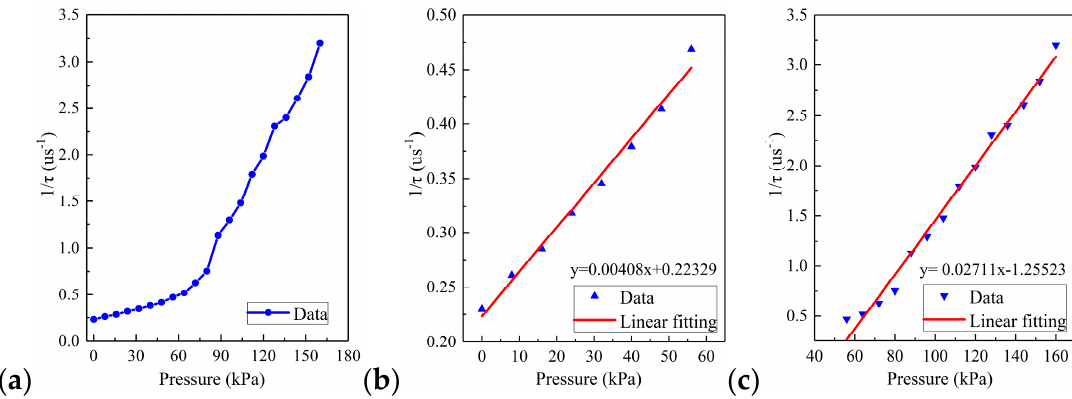
Figure 14. The relationship between the ring-down time and static ice pressure on the bottom; ( a ) ring-down time-pressure curve of the overall range of sensor; ( b ) calibration curve of the low-pressure area; ( c ) calibration curve of the high-pressure area.